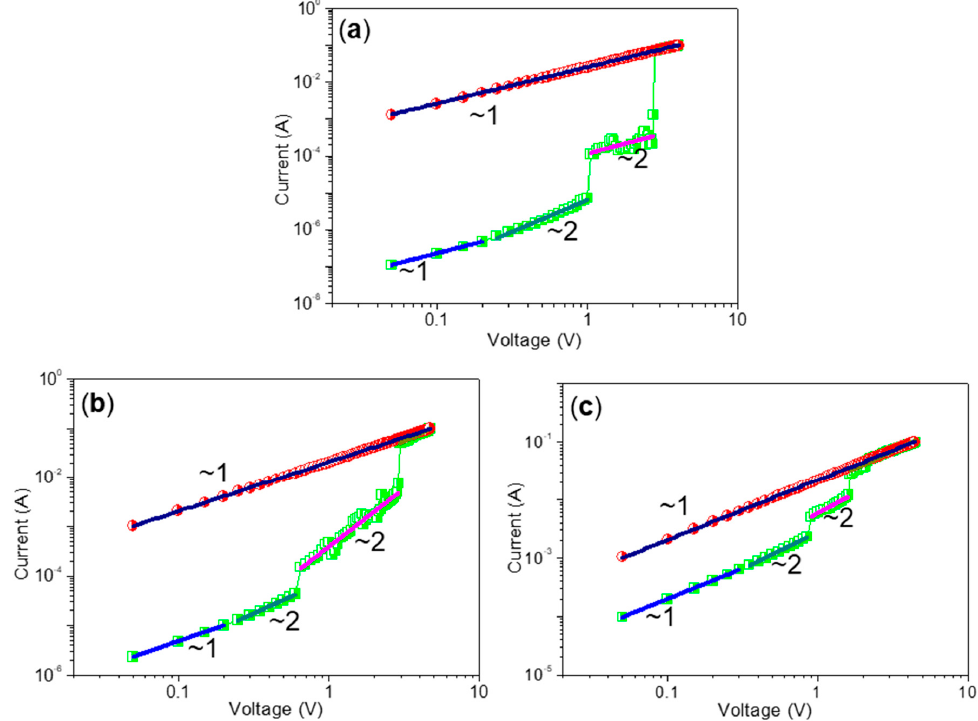
Figure 12. log I –log V curves with fitted conduction mechanism under positive (1st and 2nd sweep) DC sweeps in ITO/CS:GO/Ni devices with weight ratio of chemical component CS:GO ( a ) 2:1, ( b ) 5:1, and ( c ) 10:1 w/w, respectively.